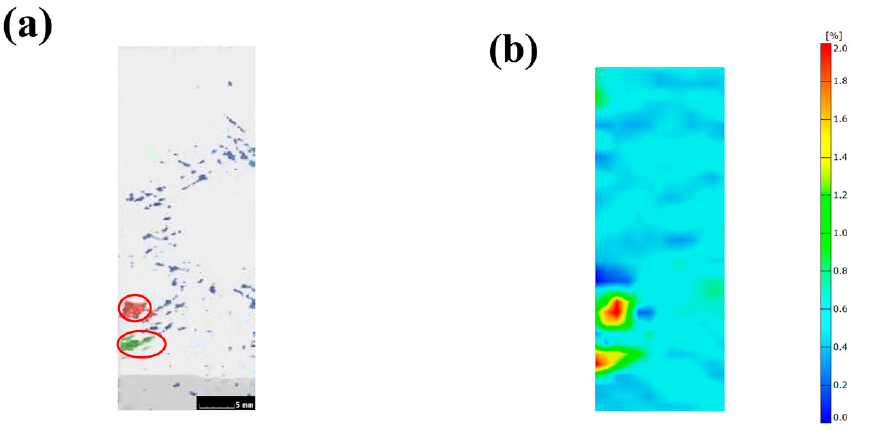
Figure 8. ( a ) The distribution of internal voids; ( b ) strain fields obtained by the DIC system.